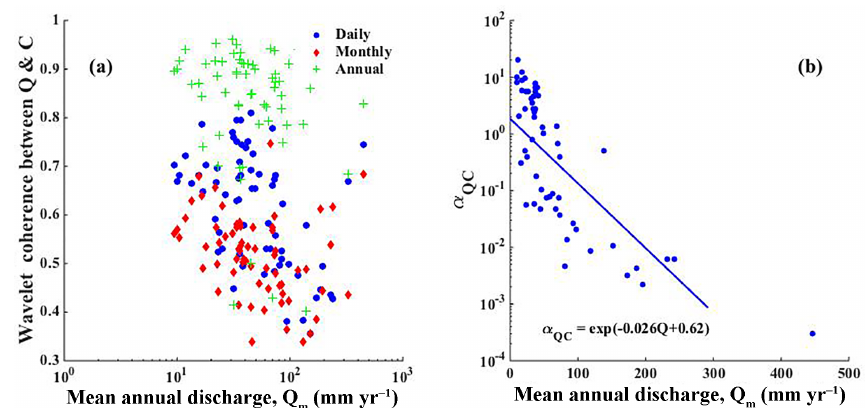
Figure 1. Scatter plots between long-term mean annual discharge ( Q m ) and (a) wavelet Q – C coherence at daily, monthly, and annual scales from the 68 study gauges and (b) slope of the discharge–sediment-concentration regression ( α QC ) at an annual scale from the 68 study gauges ( R 2 = 0 . 55 and p value < 0 . 0001).